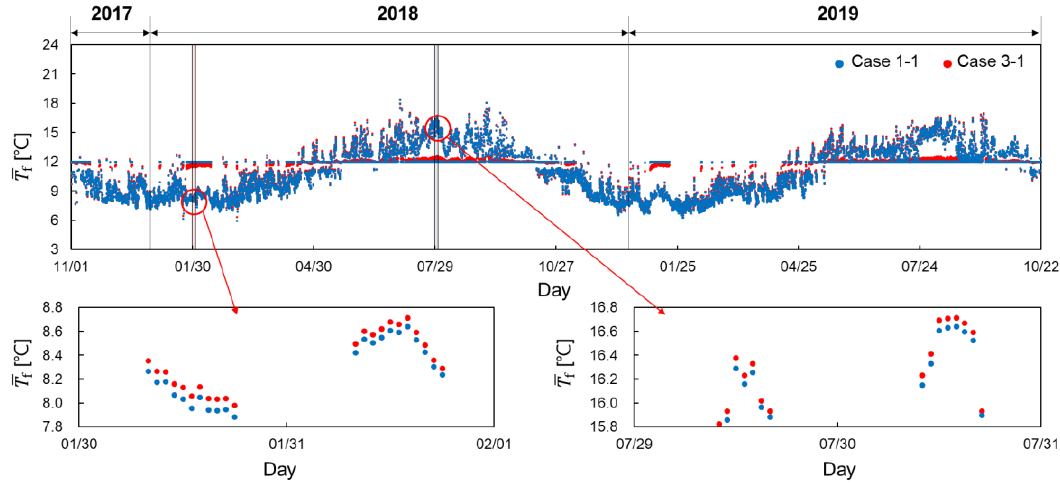
Figure 16. Average temperature variation of the circulating fluid; comparison between the proposed method and the conventional TRT analysis method.